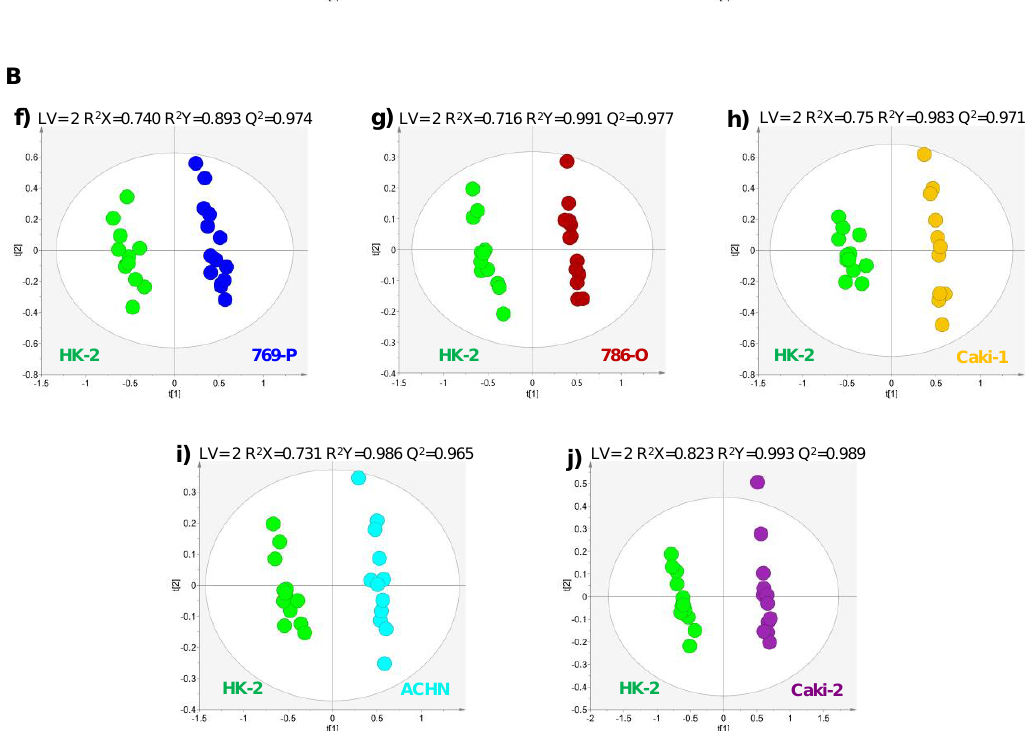
Figure 2. Pairwise partial least squares-discriminant analysis (PLS-DA) scores scatter plots obtained for the HS-SPME / GC–MS chromatogram data of ( A ) VOCs and ( B ) VCCs of culture media of each tumor cell line vs. the non-tumor cell line. ( a , f ) 769-P (dark blue, n = 13) vs. HK-2 (green, n = 12), ( b , g ) 786-O (red, n = 14) vs. HK-2 (green, n = 12), ( c , h ) Caki-1 (yellow, n = 11) vs. HK-2 (green, n = 12), ( d , i ) Caki-2 (purple, n = 12) vs. HK-2 (green, n = 12) and ( e , j ) ACHN (light blue, n = 12) vs. HK-2 (green, n =